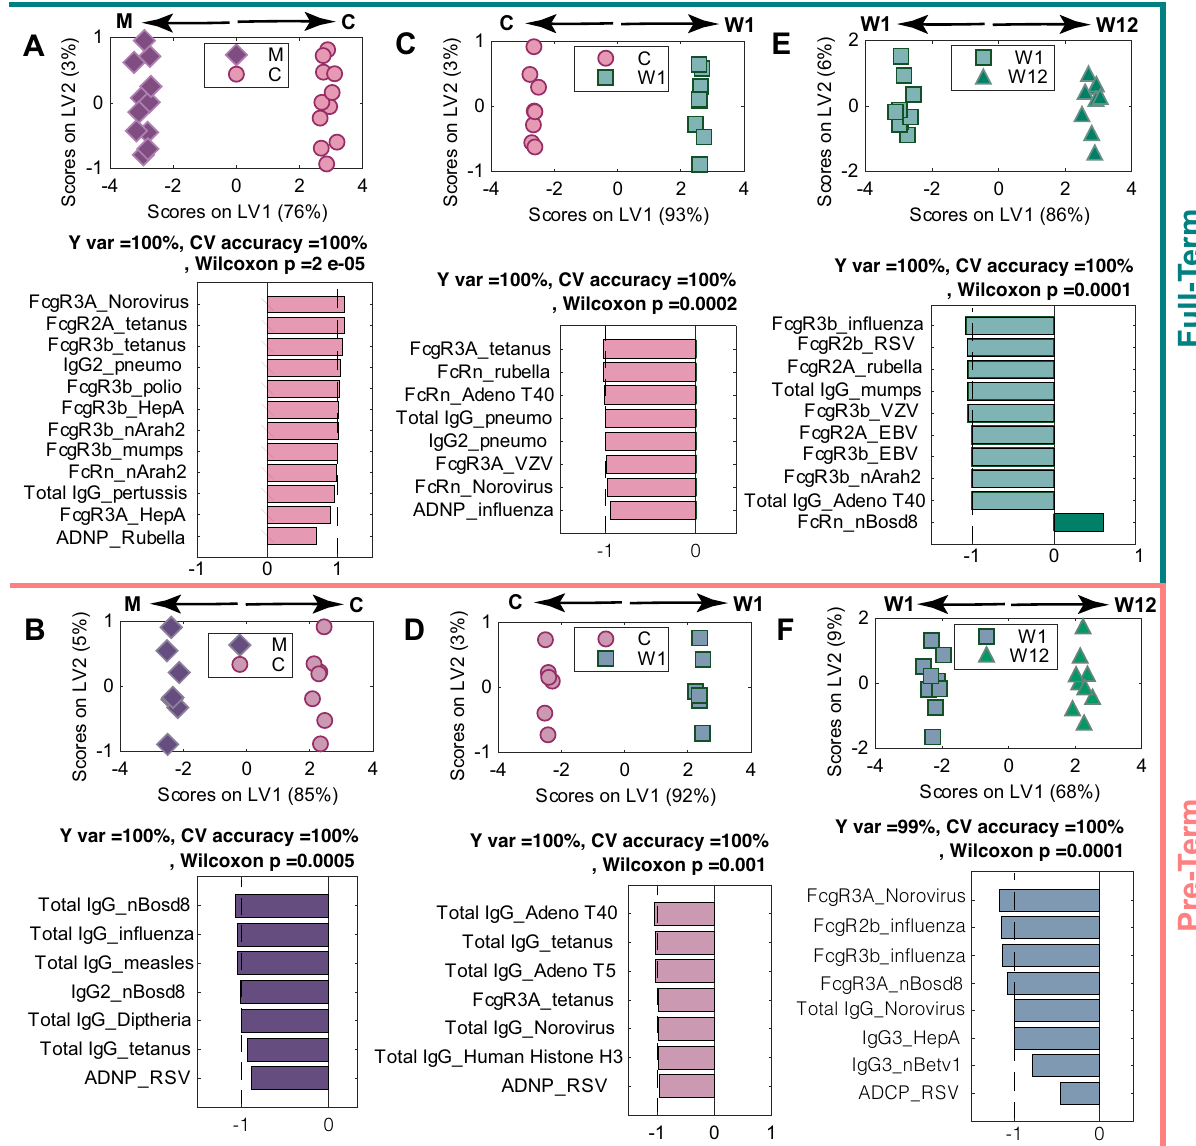
Figure 7. Similar antigen-specific decay patterns occur following birth in PT and FT infants. Separate ML-PLSDA models were constructed for PT and FT infants using LASSO-selected features to examine the evolution of antibody profile changes over time in the maternal:cord ( A , B ), across cord:week 1 ( C , D ), and between week 1 and week 12 ( E , F ). ( A ) The ML-PLSDA scores plot model separating maternal and cord antibody profiles in FT neonates is shown on top. The model captures 100% of the Y-variation. The bar plot depicts the VIP scores for loadings on LV1, which are signed and colored to reflect which group they are enriched in. The dashed line marks the threshod of VIP score = 1 above which are the top contributors to the separation. A fivefold cross validation of (CV) the model resulted in CV accuracy of 100%. This model significantly outperformed label-shuffled random models (Wilcoxon p = 2 × 10 –5 ). ( B ) The ML-PLSDA scores plot shows the separation in maternal and cord antibody profiles in PT children. The bottom bar plot illustrates the VIP scores for loadings on LV1. The bars point to the direction of higher abundance, which are dominantly found in the maternal plasma. A fivefold cross validation of the model resulted in a CV accuracy of 100%. The model outperformed models based on randomly label-shuffled inputs (Wilcoxon p = 0.0005). ( C , D ) Similar models are shown for cord and week 1 profiles for full-term and PT infants are depicted in Panels with a CV accuracy of 100% for both models, with permutation test Wilcoxon p-values of 0.0002 and 0.001 for PT and FT infants, respectively. ( E–F ) The ML-PLSDA models show the week 1:week 12 profiles for FT and PT children with CV accuracy of 100% and Wilcoxon p-values for the permutation testing of 0.0001 for both models. IgM, IgA1, and IgA2 are excluded from all analyses to focus on IgG-specific